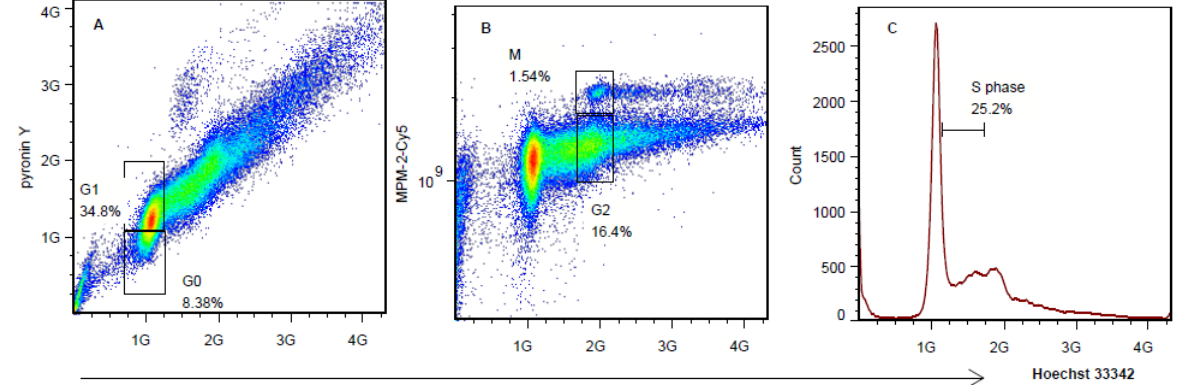
Figure 2. Distribution of cell cycles in Jurkat cells and the bivariate distribution of DNA content (Hoechst 33342), RNA content (pyronin Y), and mitotic phosphoproteins (MPM-2-Cy5 fluoresence) in Jurkat cells. ( A ) The bivariate dot plots showing DNA content (x axis = Hoechst 33342 fluorescence) and RNA content (y axis = pyronin Y fluorescence). The gates were drawn according to the negative control. ( B ) The bivariate dot plots showing DNA content (x axis = Hoechst 33342 fluorescence) and mitotic phosphoproteins content (y axis = MPM-2-Cy5 fluorescence). ( C ) DNA content histogram of Jurkat cell line, stained by Hoechst 33342. Data were obtained in three